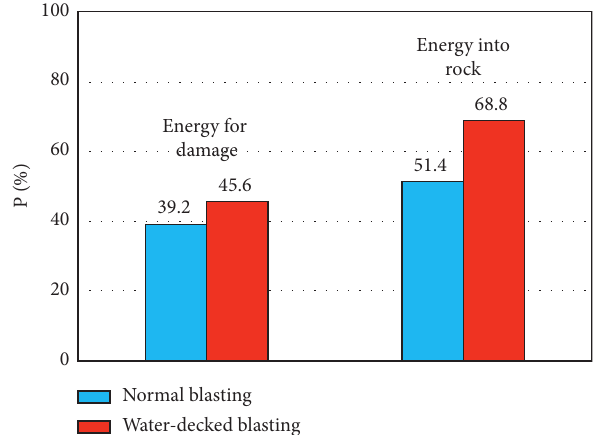
Figure 6: Energy distribution of two types of charge patterns.